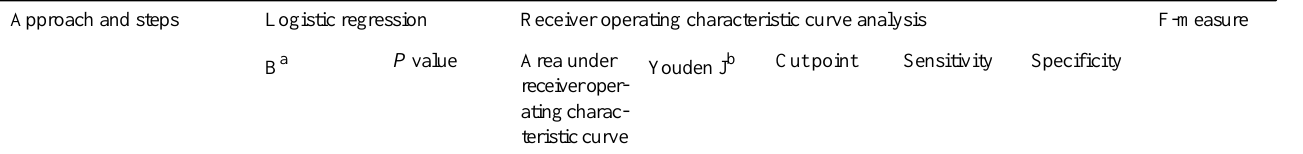
Table 3. Comparisons of area under receiver operating characteristic curve for the study models.